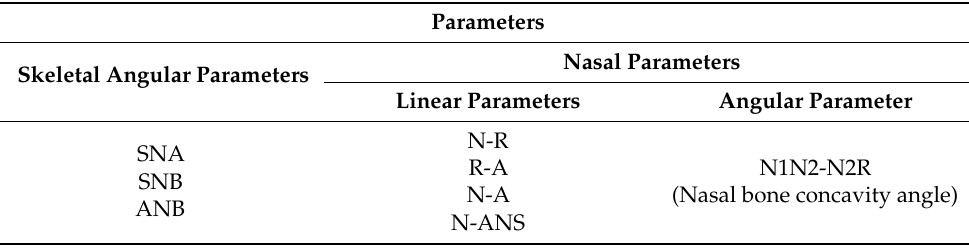
Table 1. Parameters used in the